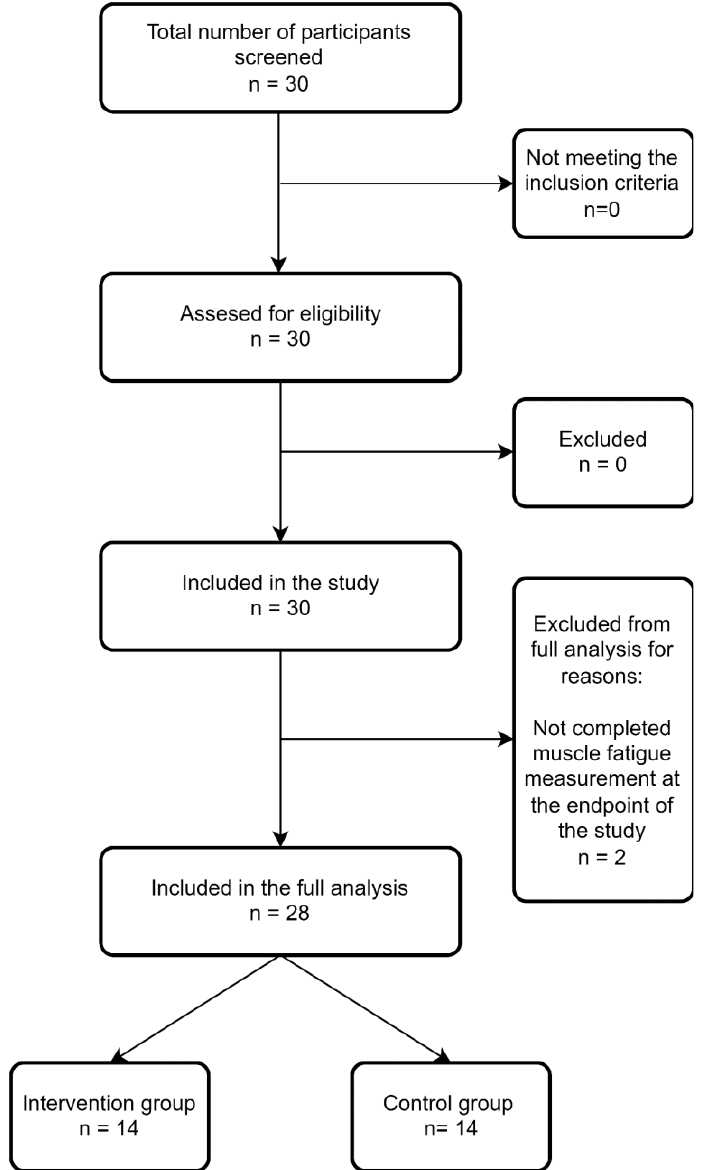
Figure 2. Study participants flowchart.